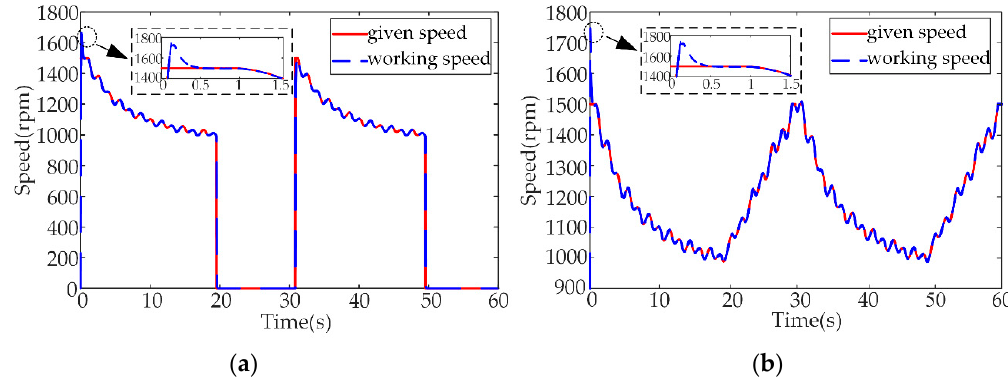
Figure 6. Accumulator pressure under regular incident waves.